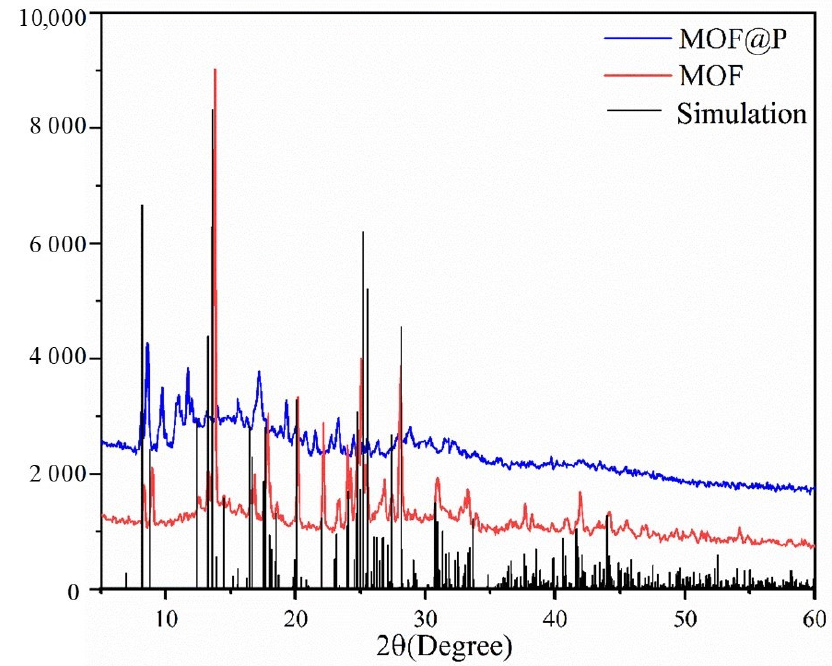
Figure 4. XRD patterns of the simulated MOF, prepared MOF, and MOF@P.